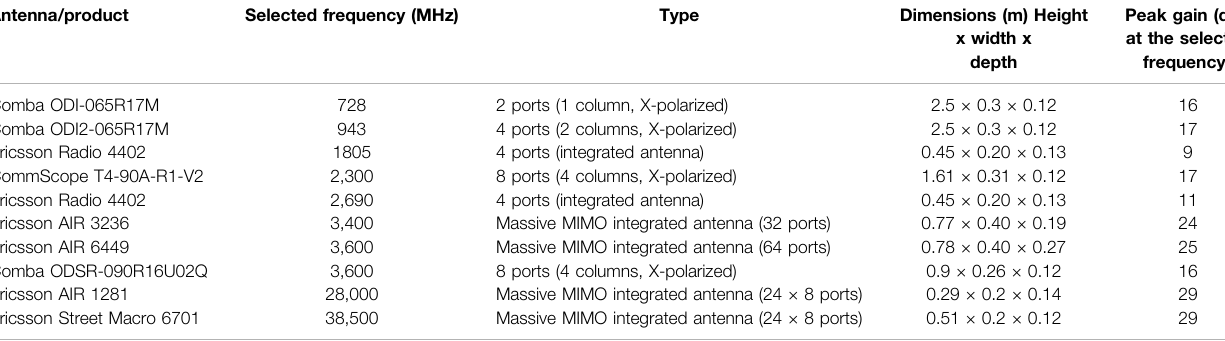
TABLE 2 | Characteristics of the selected BS antennas or BS products (for integrated antennas). Antenna/product